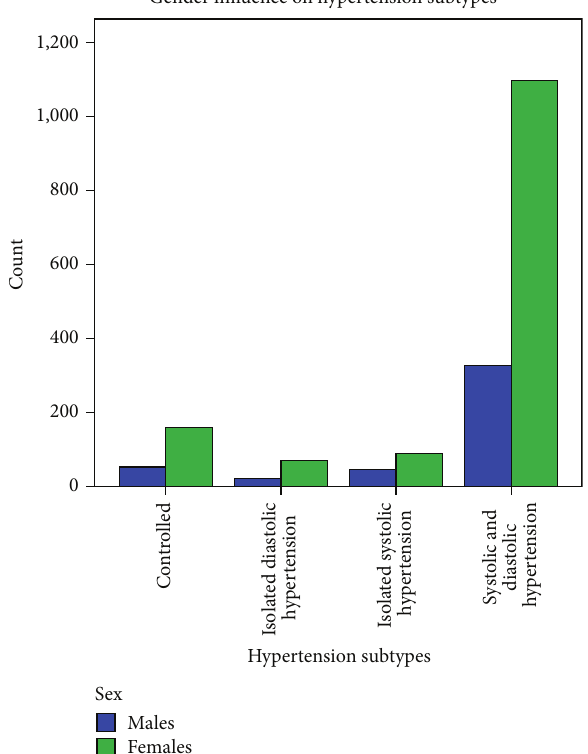
Figure 2: Gender influence on hypertension